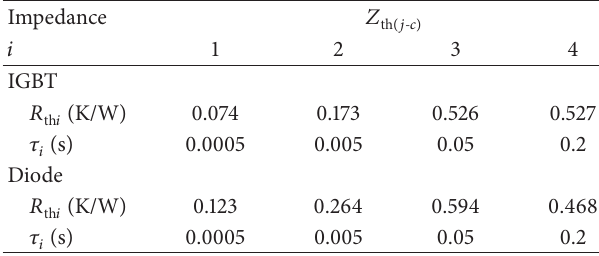
Table 1: Thermal impedance parameters of power switching devices from a leading manufacturer according to Figure